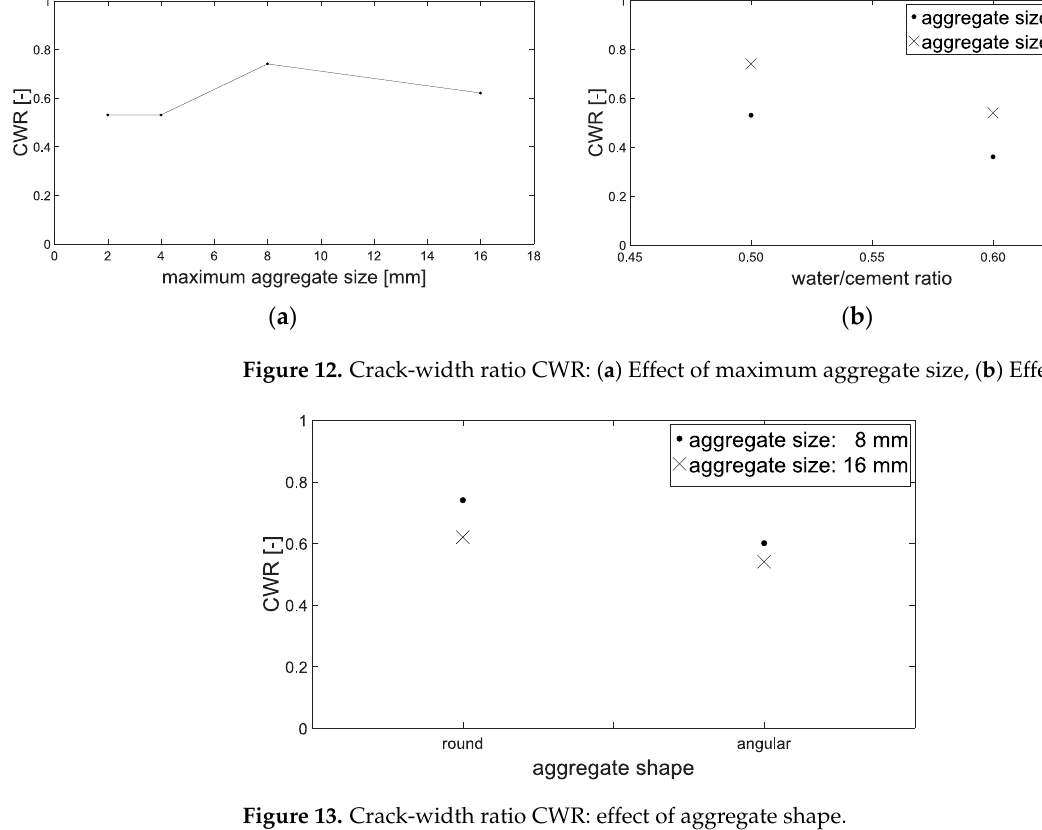
Figure 13. Crack-width ratio CWR: effect of aggregate shape.